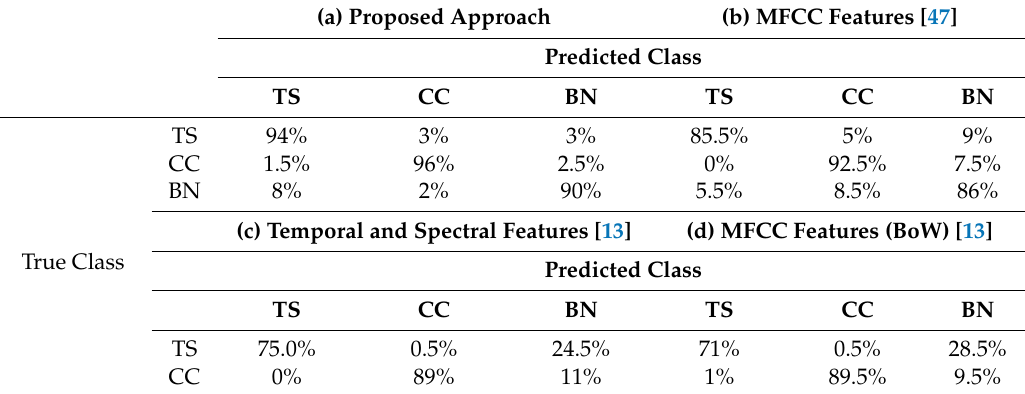
Table 4. Classification matrices achieved using ( a ) the proposed approach, ( b ) the MFCC features proposed in [47], ( c ) the method defined in [13] with temporal and spectral features and ( d ) the method defined in [13] with MFCC Features using Bag of Word (BoW)